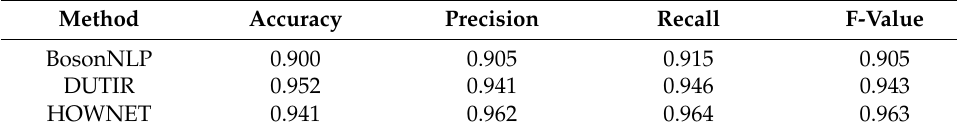
Table 12. Evaluation indicators for different